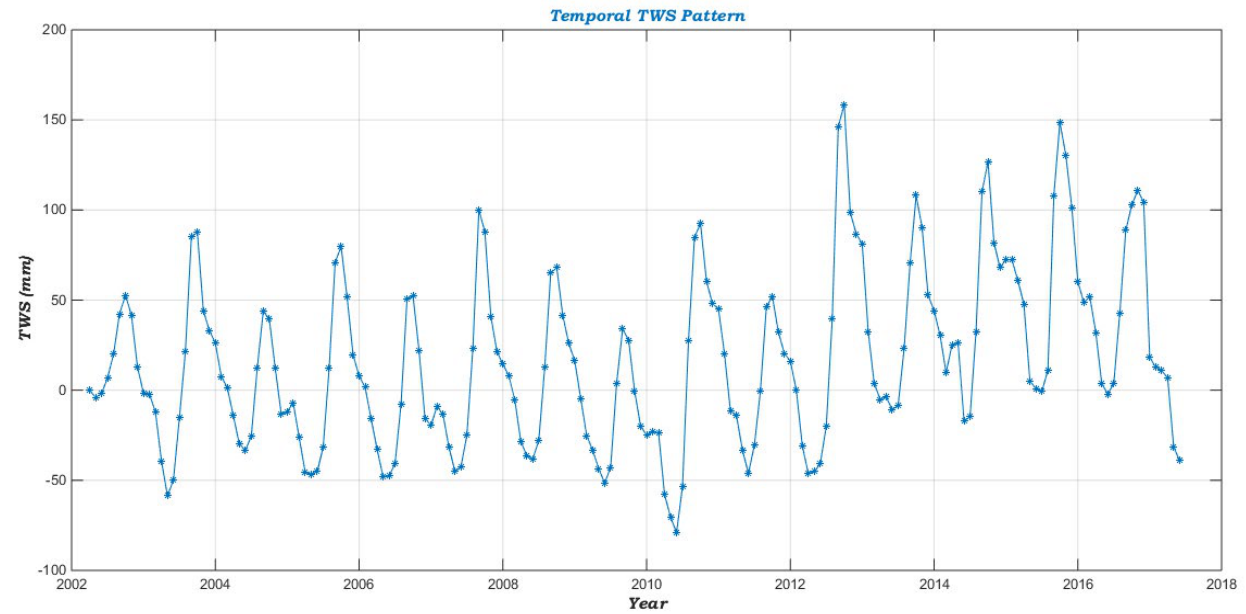
Figure 3. Temporal Pattern of TWS over Nigeria (2002-2017) Another visible pattern in the time series that calls for extra attention, is the inter-annual pattern inherent in the peak values. TWS has been identified as an indicator for regional climate. Egbuawa et al (2017) confirm that trends in El Nino Southern Oscillation (ENSO) originating from Indian and Pacific Ocean affect regional climates in Nigeria. They further linked coastal flooding of 2012 and the intensive dust haze of 2015 in southern Nigeria to the 2012 and 2015 strong El Nino events respectively.